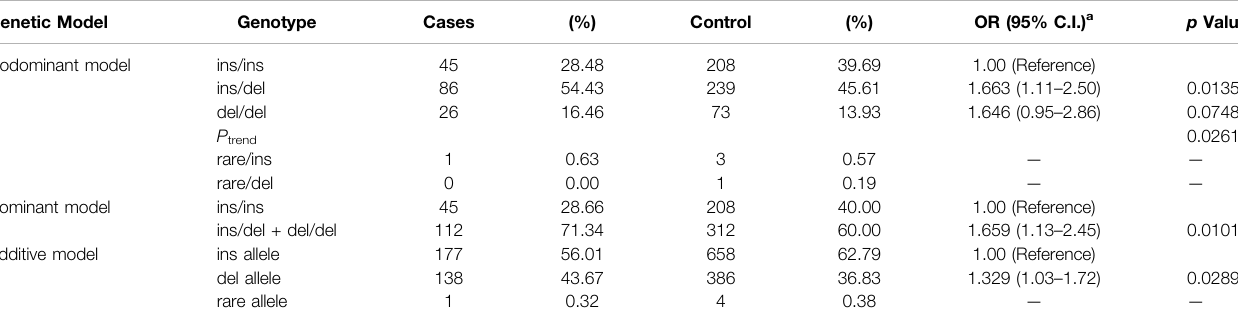
TABLE 2 | Associations between rs150703258 and sudden cardiac death susceptibility in case control sets recruited during 2012 – 2019. Genetic Model